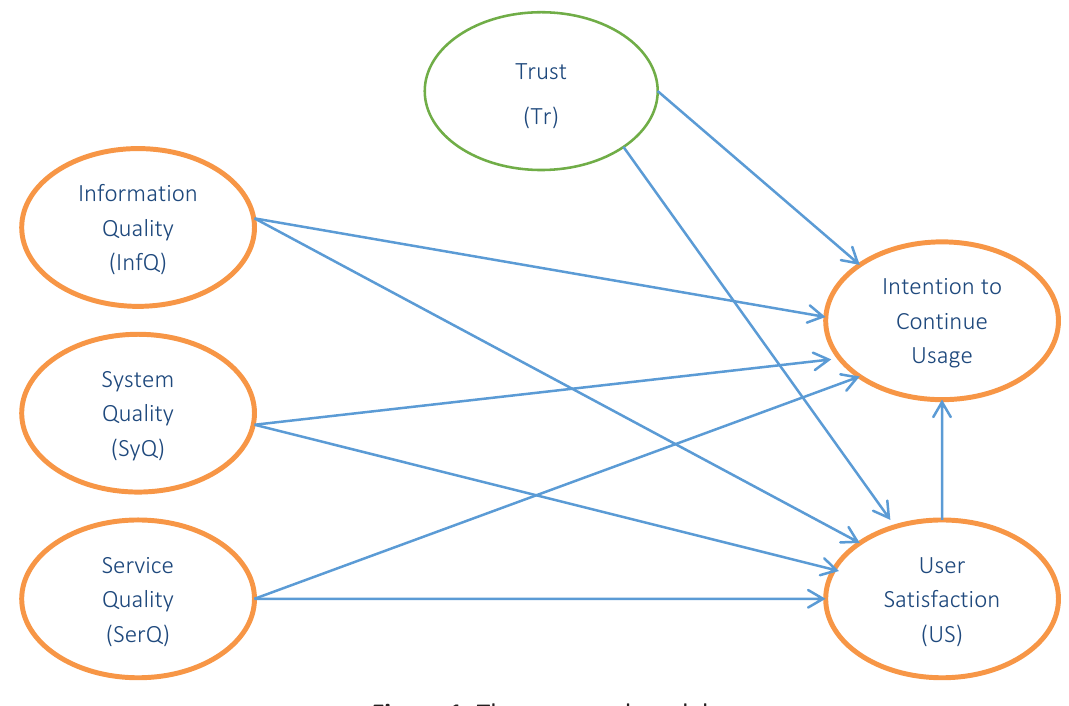
Figure 1. The proposed